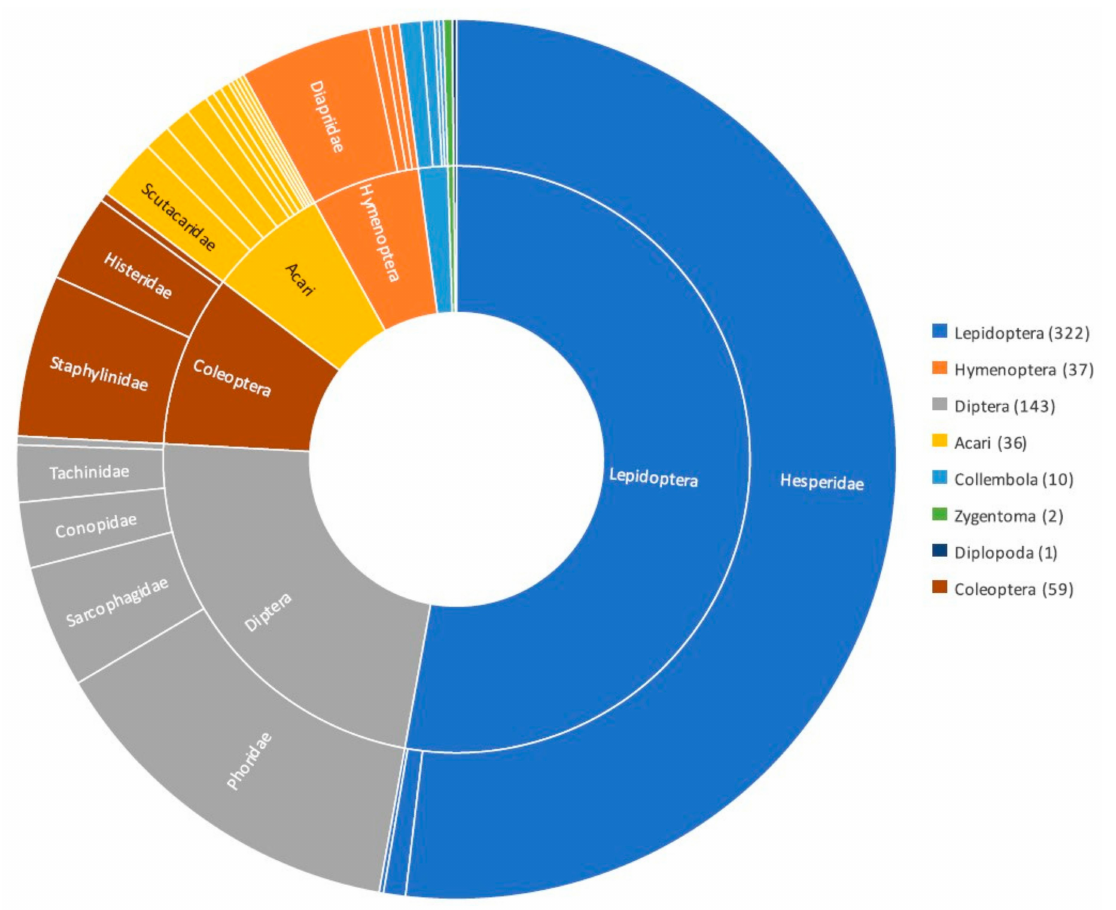
Figure 1. Diagram illustrating the different arthropod taxonomic groups found as associates of Eciton army ants. Numbers in brackets indicated number of species reported as Eciton burchellii associates; data from Rettenmeyer [69]. See Table S2 for further details of families with lower representation within each of the main arthropod taxonomic